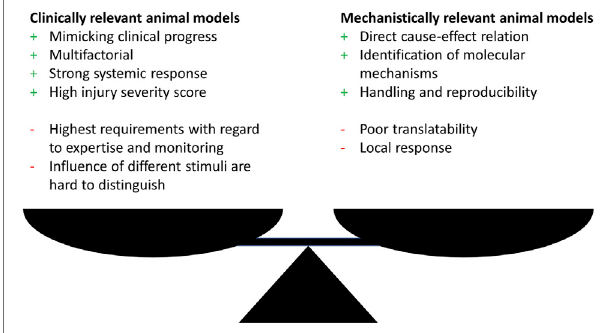
FIGURE 1 | Advantages (+) and disadvantages ( − ) of clinically or mechanistically relevant animal trauma